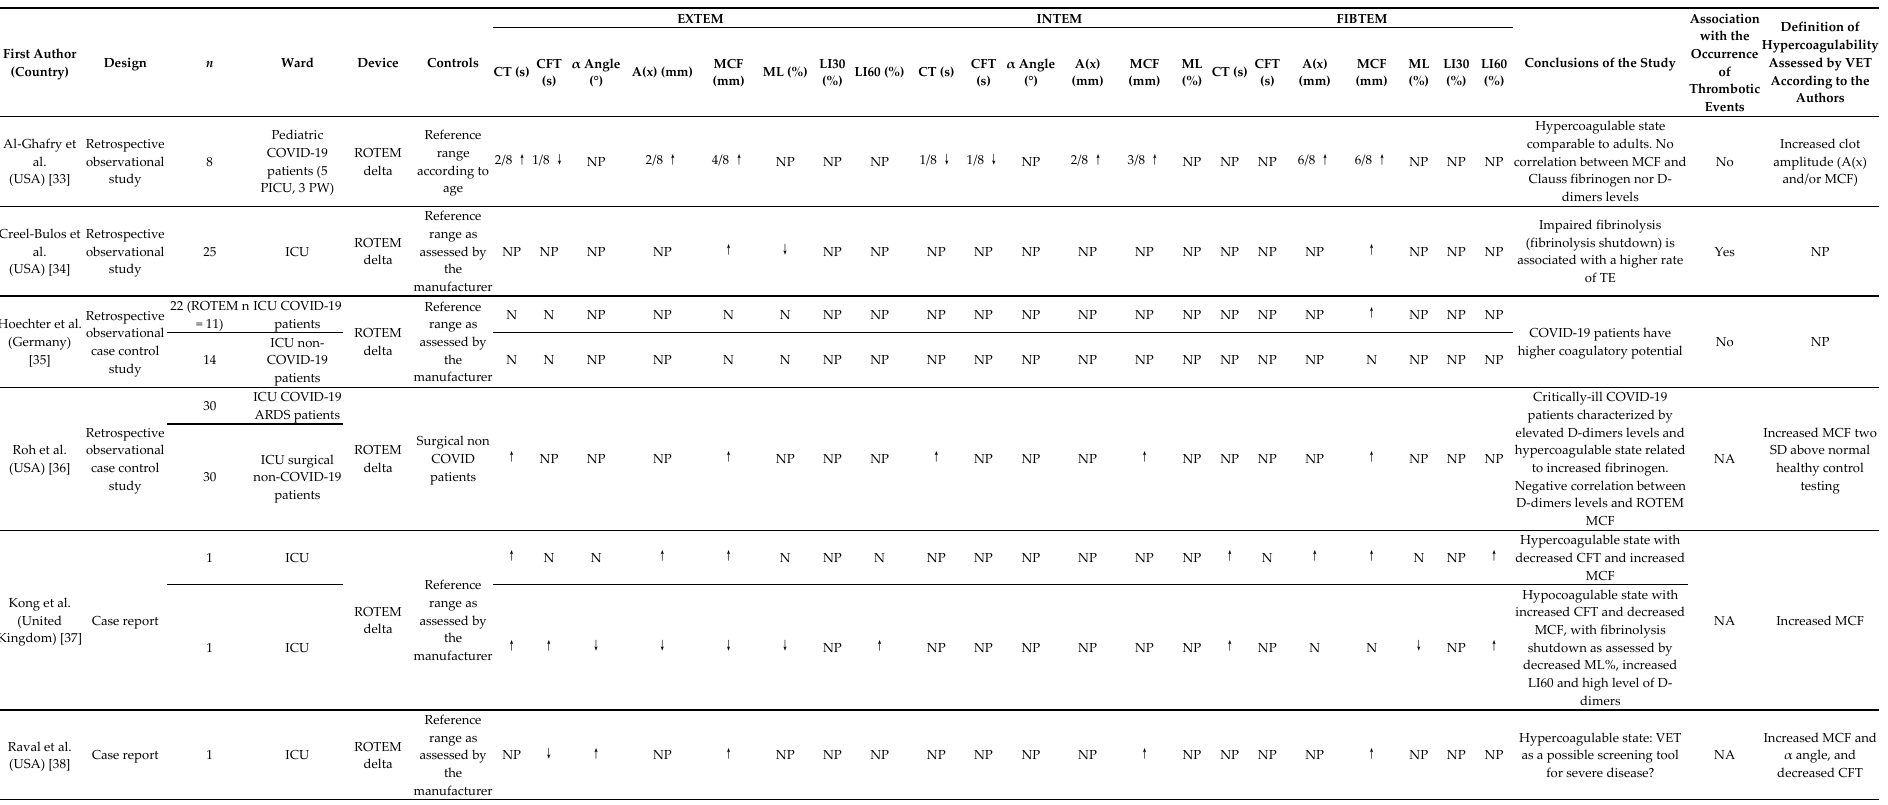
Table 5. Main findings of studies reporting ROTEM results (except APTEM and TEM-tPA